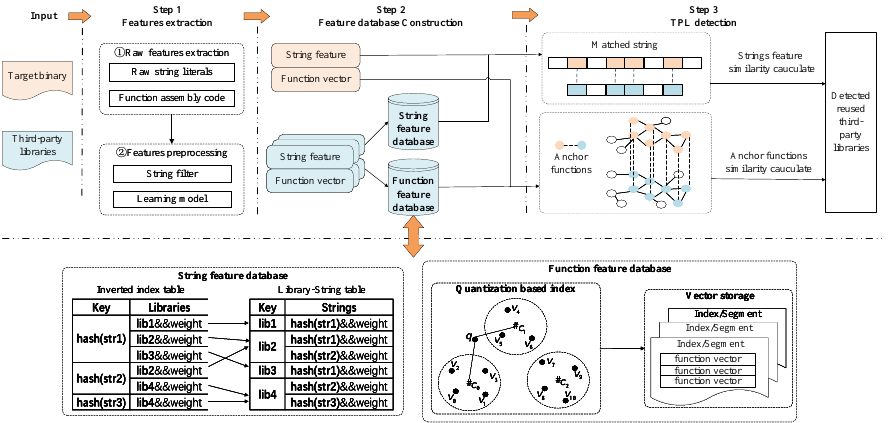
Figure 1. Overview of